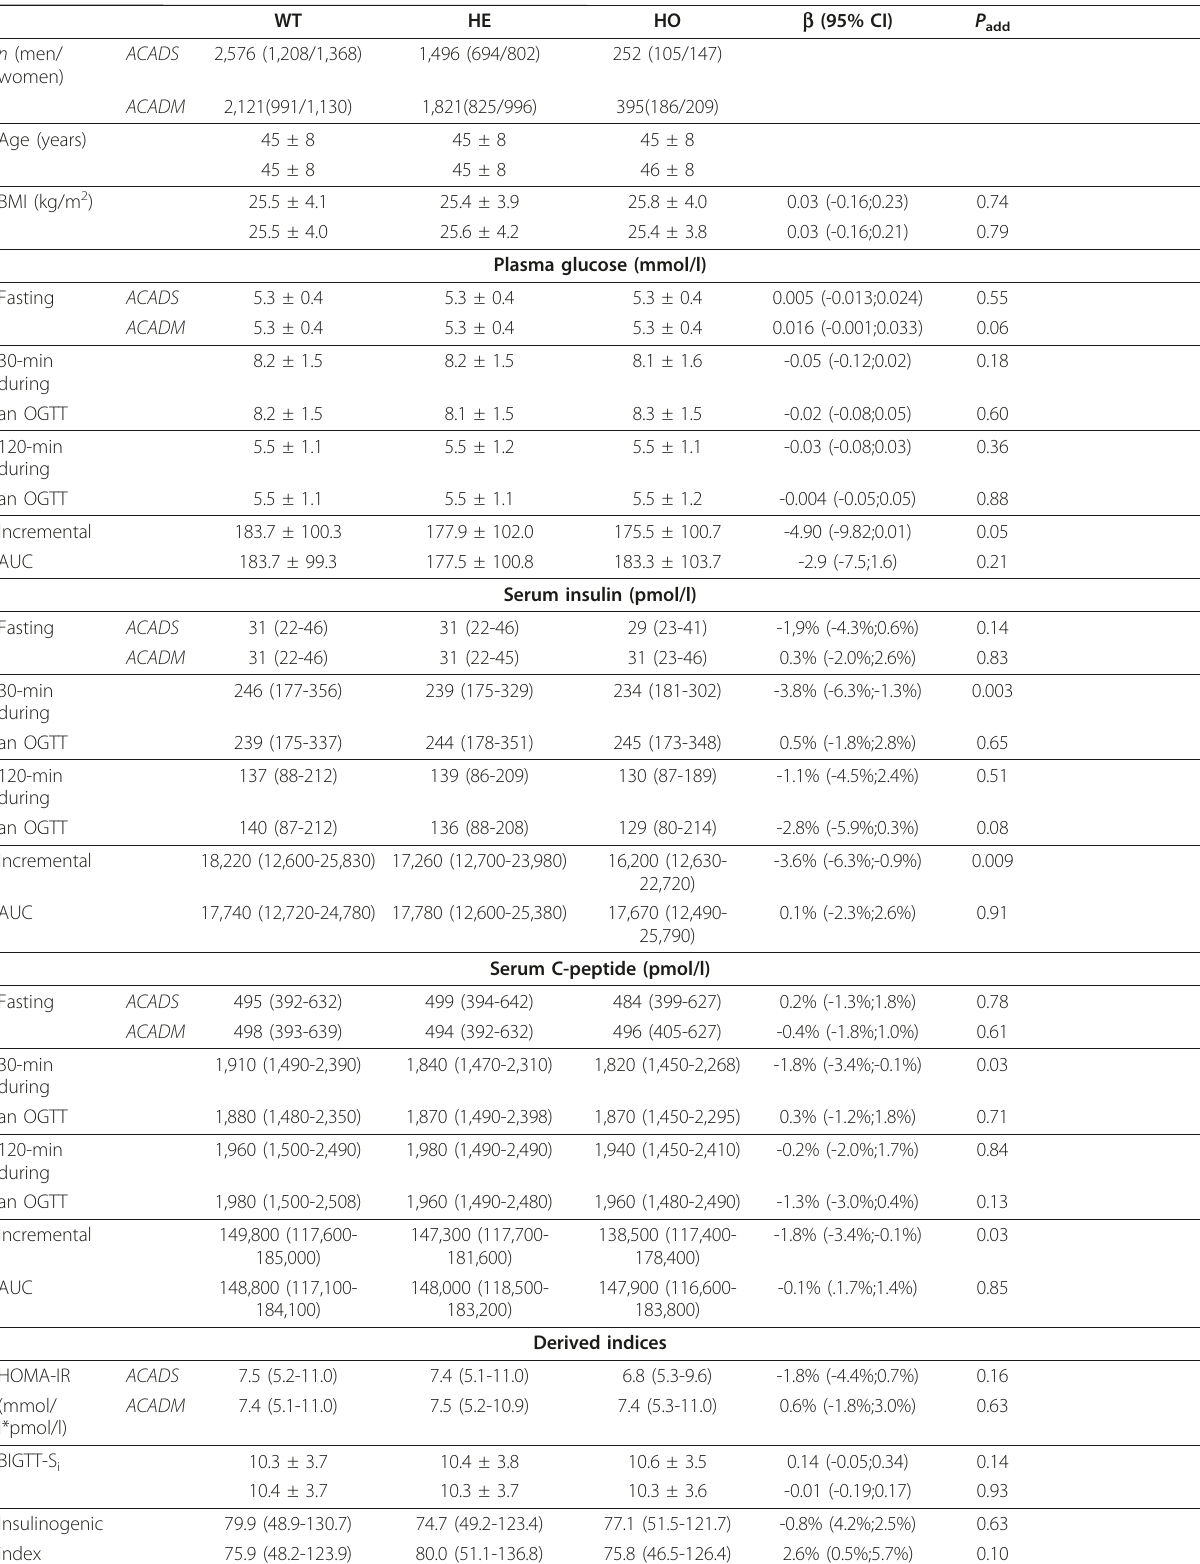
Table 1 Anthropometric and metabolic characteristics of successfully genotyped glucose-tolerant Danes from the Inter99 cohort stratified according to ACADS rs2014355 (T/C) and ACADM rs11161510 (C/T) genotype, respectively WT HE HO b (95% CI) P